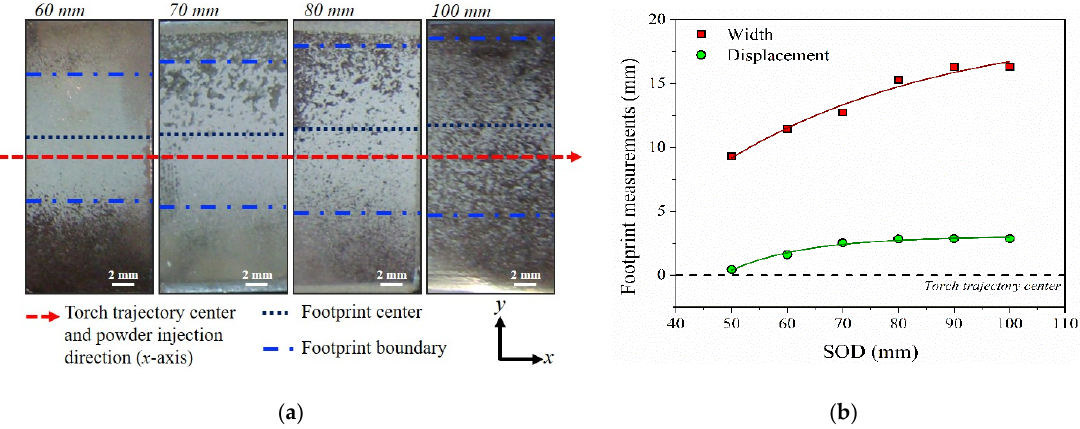
Figure 3. ( a ) Dynamic footprint photographs of samples deposited at 60, 70, 80, and 100 cm. ( b ) Width and displacement results related to torch axis of dynamic footprints of Al 2 O 3 powder obtained with a METCO 9MB plasma torch as a function of stand-off distance.